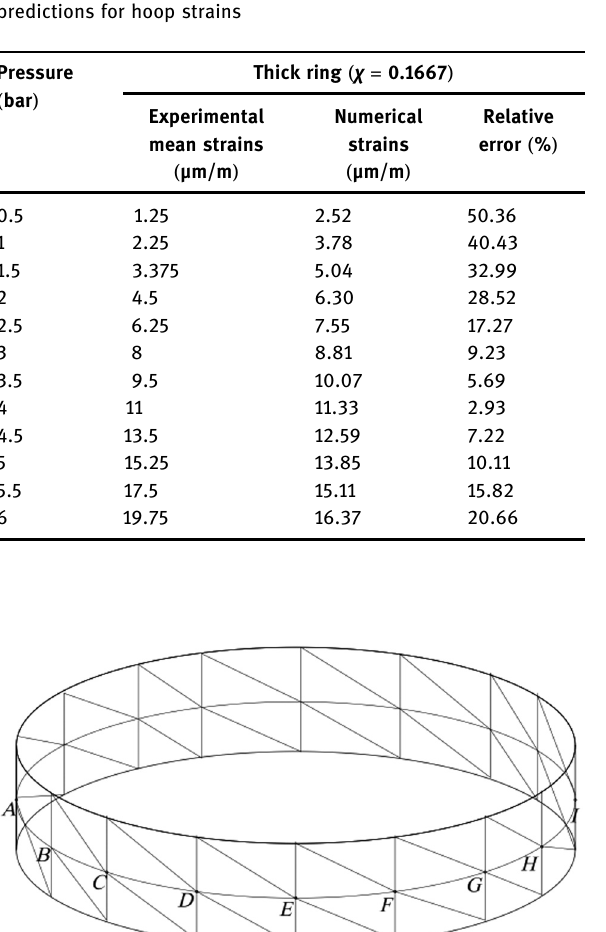
Table 4: Relative error between experimental values and model